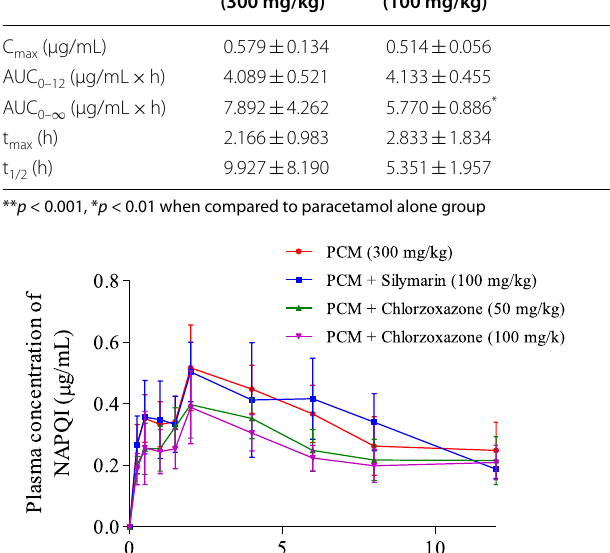
Table 2 NAPQI pharmacokinetic parameters following an oral after the oral administration of paracetamol (300 mg/kg) with or without silymarin (100 mg/kg) and chlorzoxazone (50 and 100 mg/kg) to rats